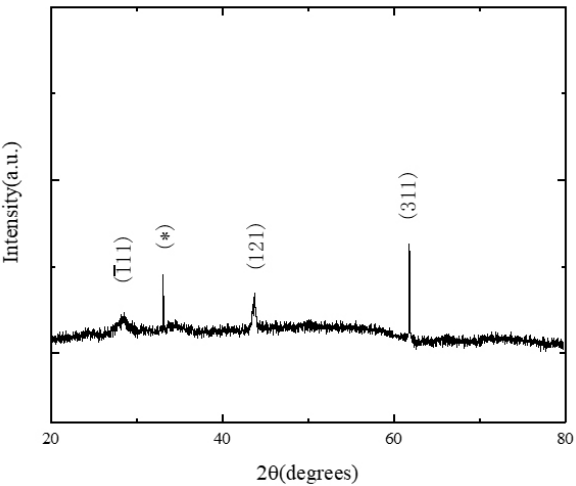
Figure 4. XRD phase diagram of HfO 2 film; * indicates the SiO 2 (217) peak.